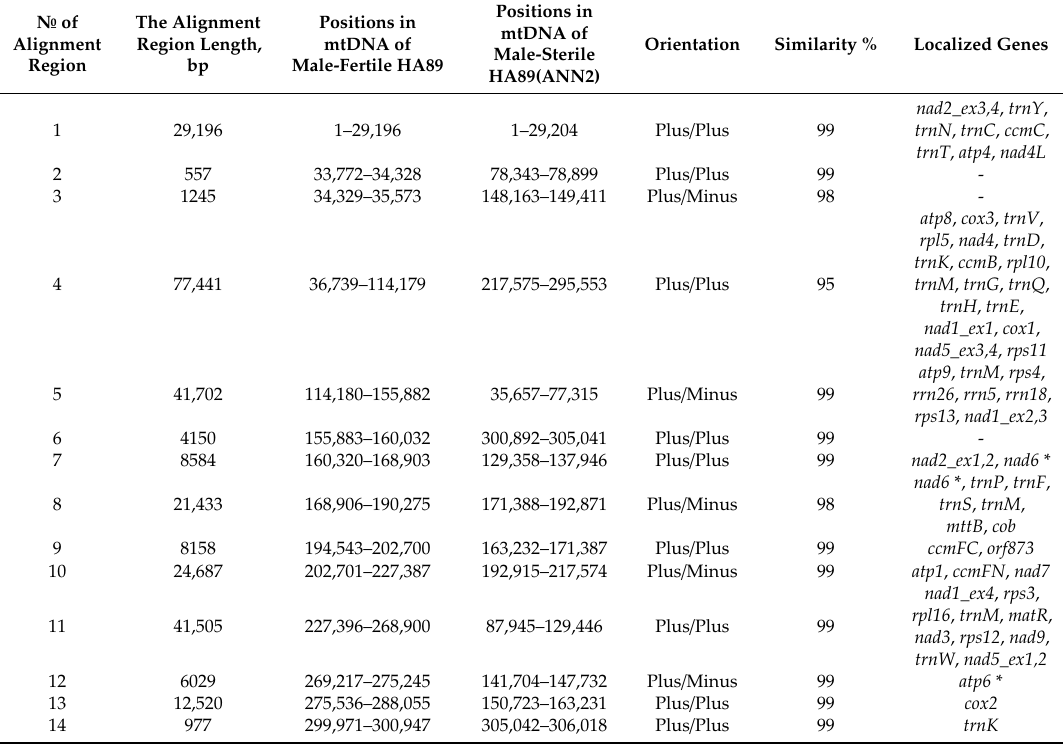
Table 1. Alignment of the mitochondrial genomes of HA89 and HA89(ANN2)